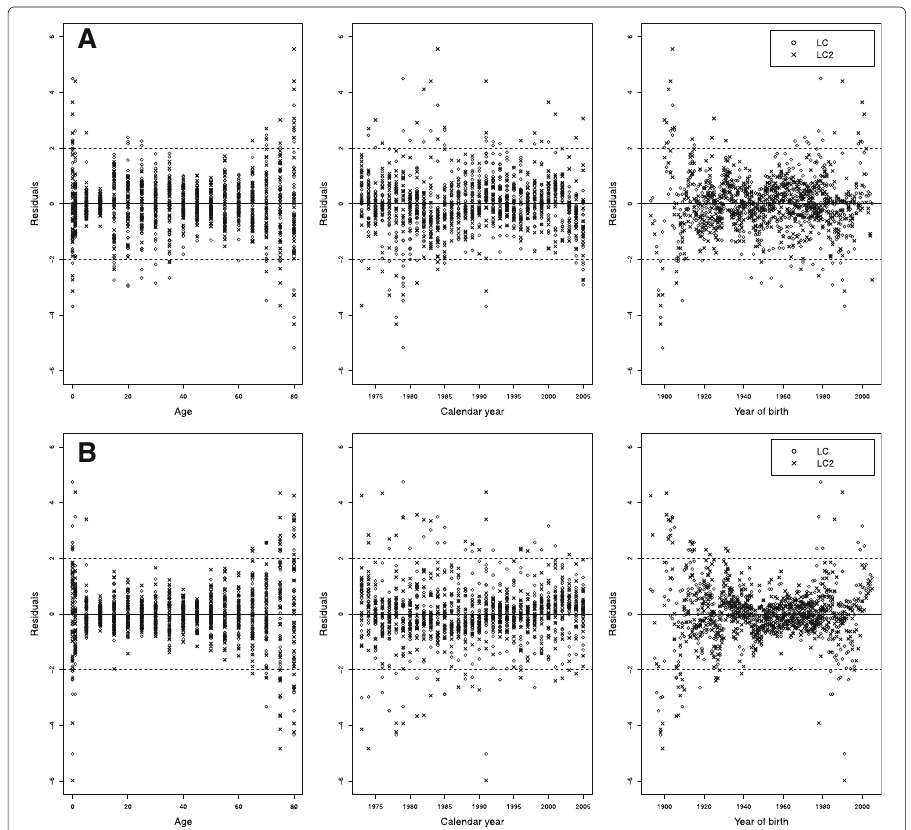
Fig. 4 Scatter plots of standardized deviance residuals for the LC and LC2 models at the period 1973–2005 (dashed lines represent the interval ( − 2, 2)). a Men. b